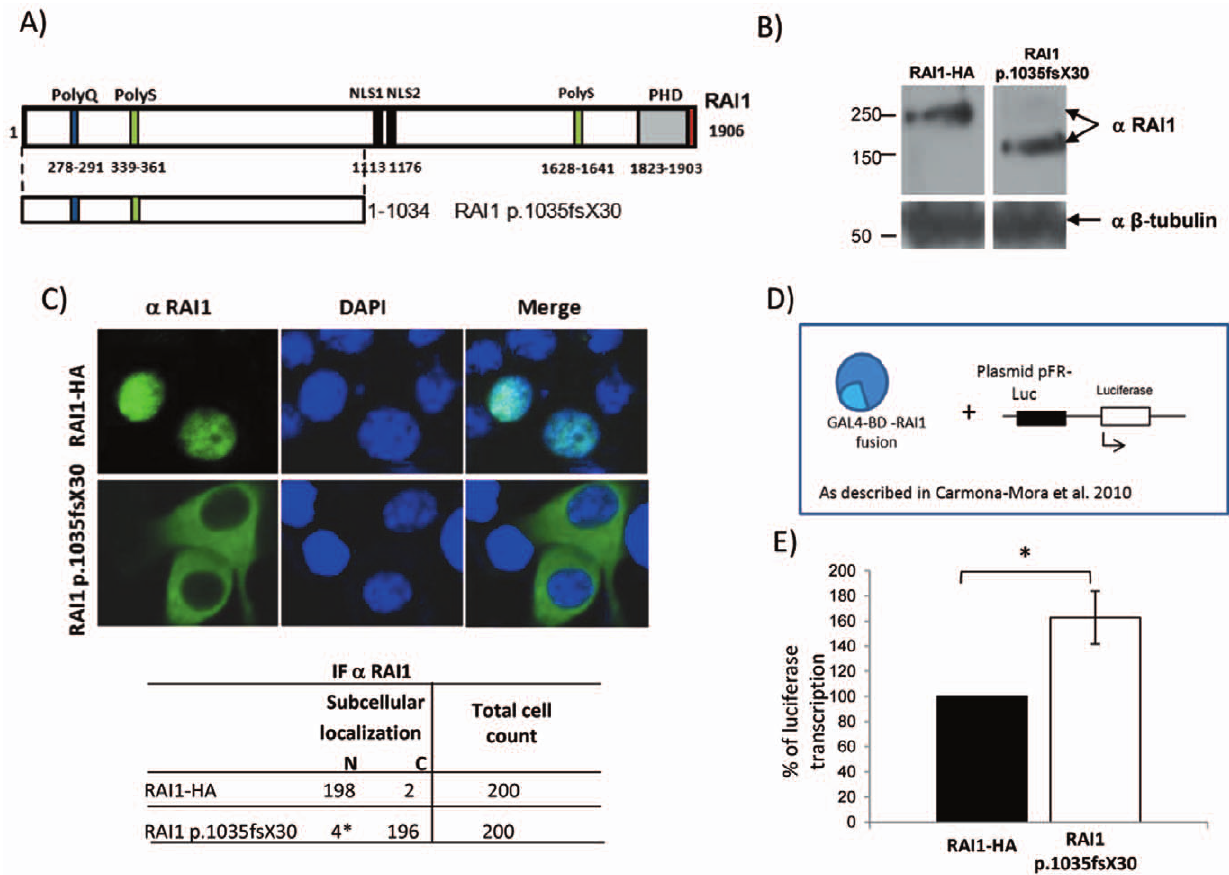
Figure 2. Molecular and cellular evaluation of the p.1035fsX30 truncated protein. A) Schematic representation of the RAI1 protein structure, which includes the polyglutamine tract (PolyQ, blue), polyserine tract (PolyS, green), bipartite nuclear localization signal (NLS, black), and the plant homeo domain (PHD, gray). The HA epitope (red) was added by PCR at the 3 9 end of full length cDNA of RAI1 isoform 1. The p.1035fsX30 truncated protein is represented below the isoform 1 of RAI1. B) Neuro-2a cells were transfected either with the clones RAI1-HA wild type or RAI1 c.3103insC (p.1035fsX30). A Western blot using an antibody against RAI1 ( a RAI1) was performed to calculate the molecular weight of RAI1 p.1035fsX30. The anti b -tubulin antibody ( a b -tubulin) was used as loading control. C) The subcellular localization of the truncated protein was assessed by immunofluorescence using anti RAI1 ( a RAI1). Neuro-2a cells were transfected with the plasmids coding for RAI1 wild type and RAI1 p.1035fsX30. As negative control, untransfected cells are also shown. Nuclei were stained with DAPI. The table indicates the subcellular localization N; nuclear, C; cytoplasmatic, of 200 cells, *: p # 0.05). D) Schematic representation of Neuro-2a cells that were co-transfected with RAI1 wild type or RAI1 c.3103insC fused with GAL4-BD (pCMV-BD), plus the luciferase reporter plasmid. b -galactosidase activity was used for normalization due to differences in transfection efficiency. E) Luciferase expression was utilized as a reporter for transactivation activity of RAI1. The wild type activity was considered as 100%. Values represent mean 6 SEM. (RAI1-HA n=9, RAI1 p.1035fsX30 n=3; *: p #